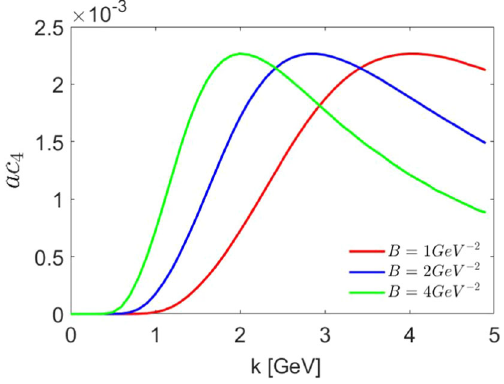
Fig. 7 The full cumulant ac 2 for different directions, θ,φ = const , k r is changing. B = 1 GeV − 2